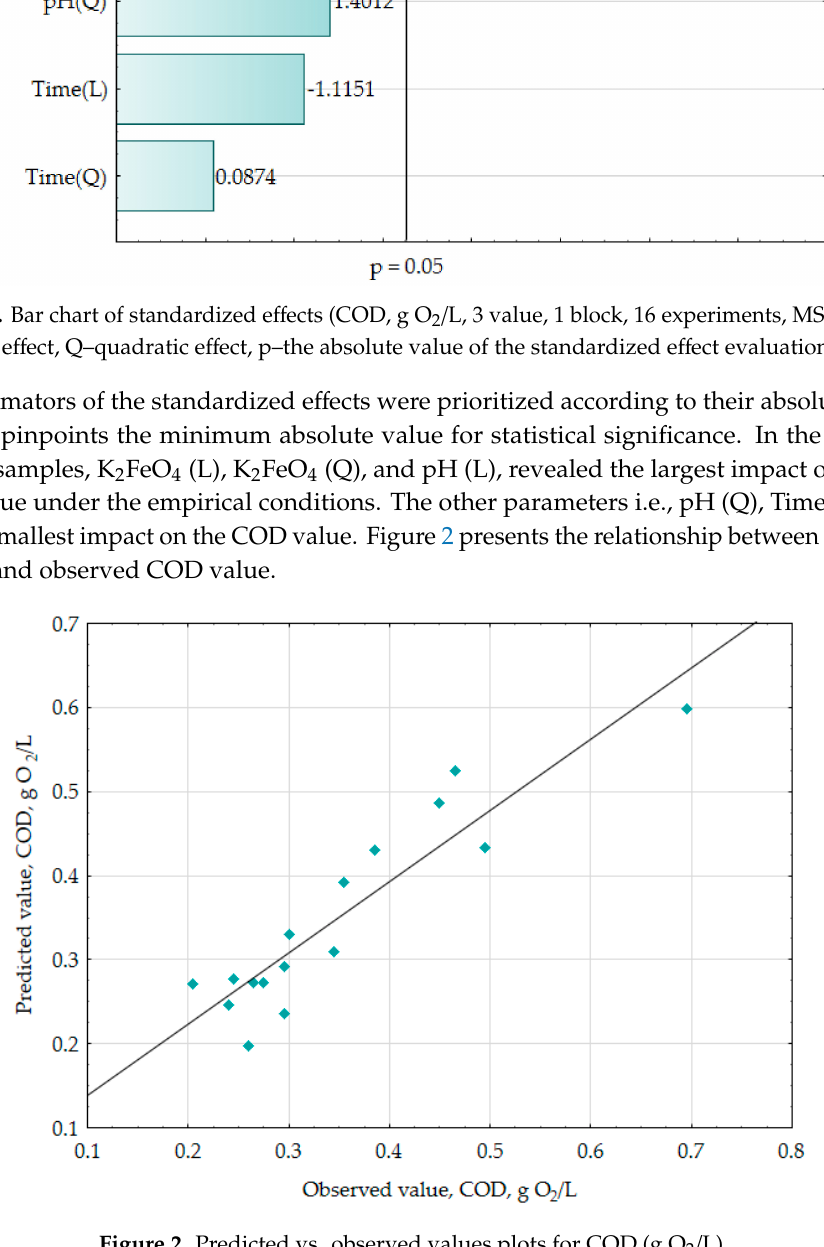
Figure 2. Predicted vs. observed values plots for COD (g O 2 /L).